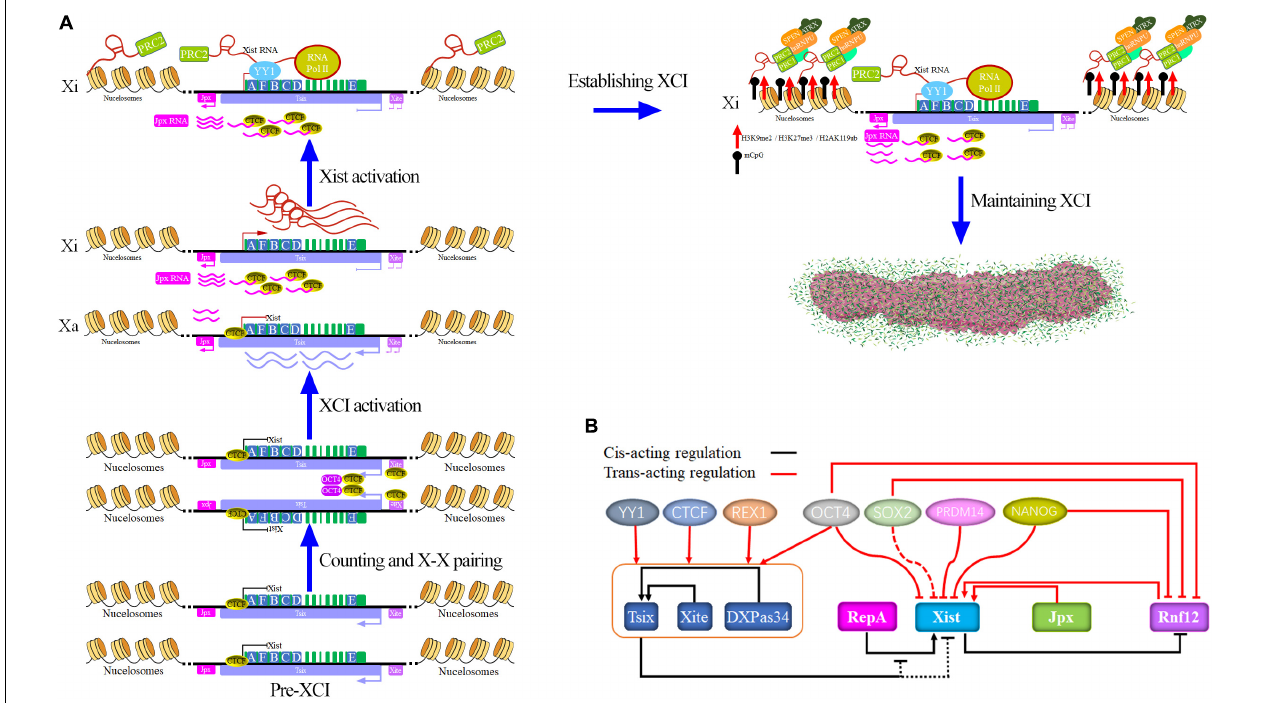
FIGURE 2 | Model for Xist and Xist regulation at the process of XCI. (A) The process of dynamic and multifaceted modulation of XCI by lncRNA Xist. lncRNA Xist is a multitasking RNA that recruits protein complexes (such as OCT4, CTCF, Tsix, Xite, PRC1, PRC2, SPEN, ATRX, hnRNPU, hnRNPK, SHARP, HDAC3, LBR, Airn, Kcnq1ot1, RBM15, WTAP, trisomy 21, U1 snRNP, Rsx, Sox2, PRDM14, Jpx, Rnf12, and RepA) to initiate, establish, and maintain the XCI state by histone modifications, DNA methylation, and H4 hypoacetylation. (B) LncRNA Xist regulation network of genetic interactions (Augui et al., 2011). Note that here arrows do not necessarily imply direct